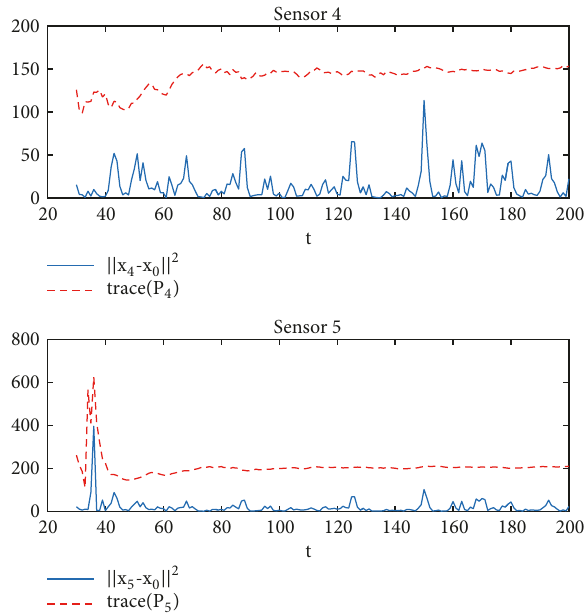
Figure 3: State estimation errors and covariances of sensors